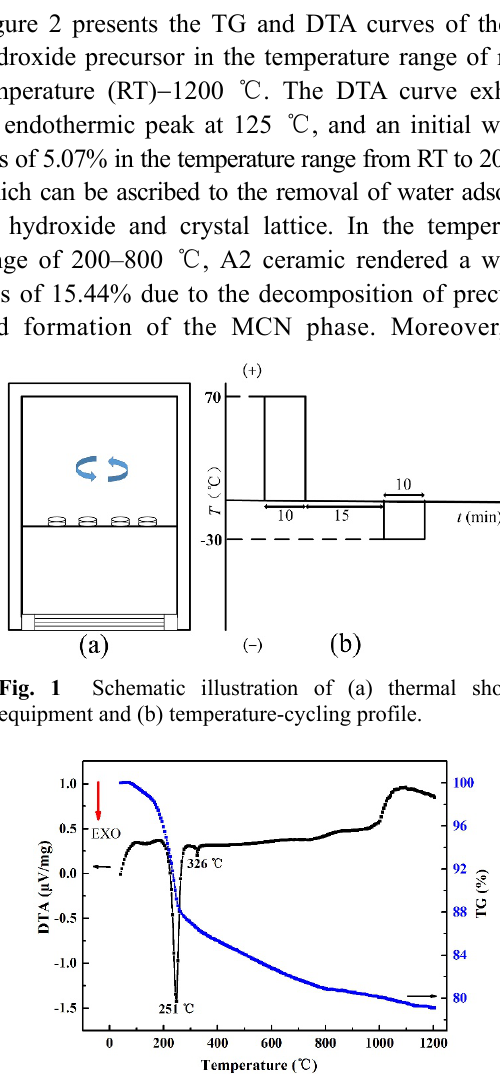
Fig. 2 TG/DTA curves of the A2 sample.